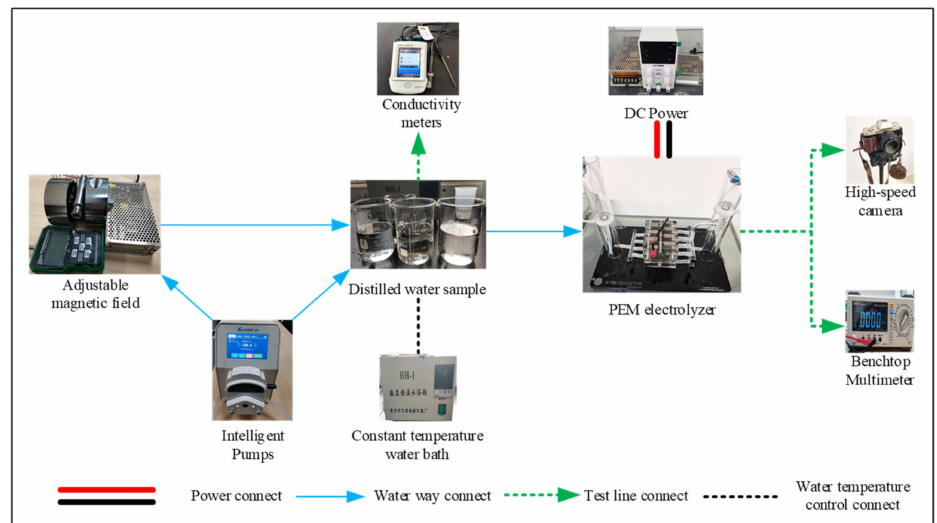
Figure 4. Schematic diagram of low-power electrolytic hydrogen production experimental device based on strong magnetic